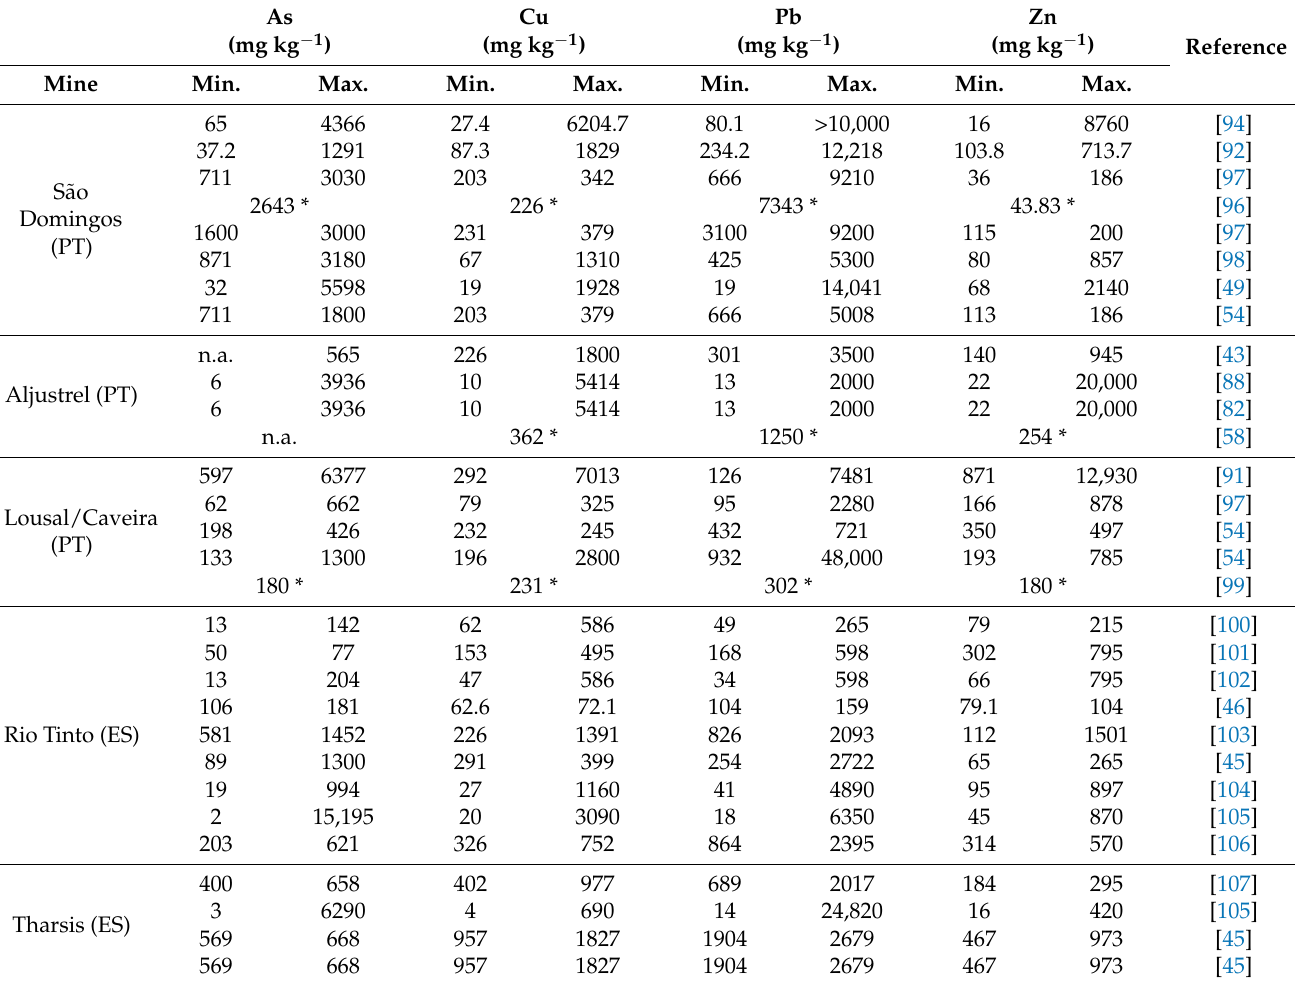
Table 2. Indicative concentrations for As, Cu, Pb and Zn (minimum and maximum, or medium (*), when that value is reported) found in different mines of the Iberian Pyrite Belt (Portugal: PT; Spain: ES). n.a.: not